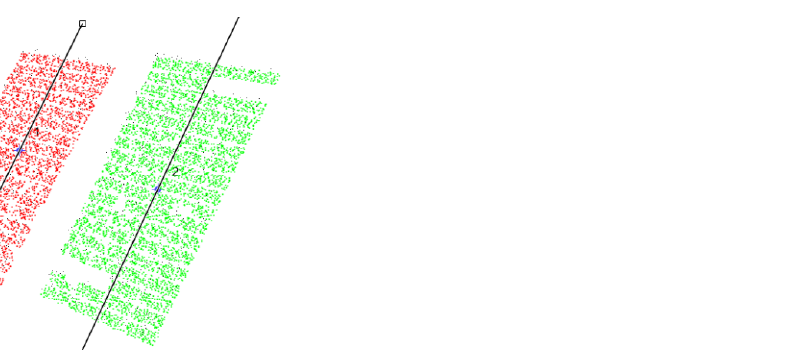
Figure 7. Isolation of the PV panels by image treatment (no fault).